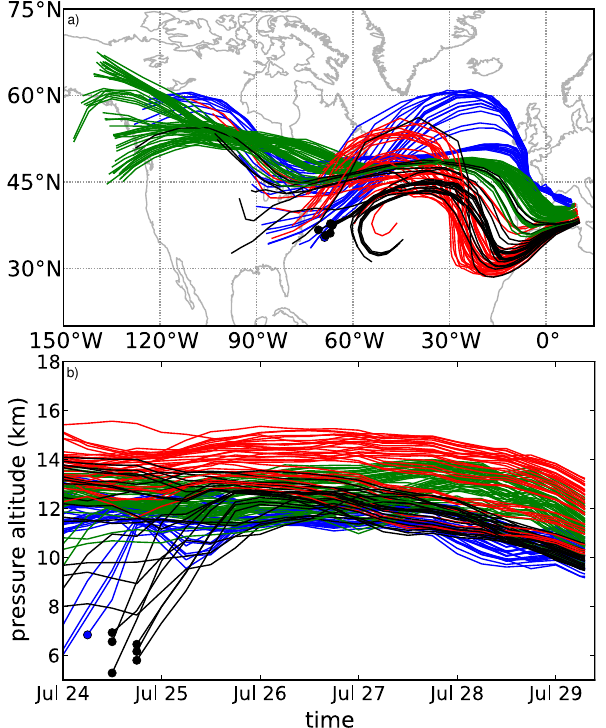
Fig. 7. Backward-trajectories of four groups of selected air parcels. (a) and (b) show the horizontal and vertical course of the trajecto- ries, respectively, for the five days preceding the measurement. The backward trajectory is terminated, if the parcel “sinks” below 7km, whereby this last position is marked by a coloured dot. See also Fig.